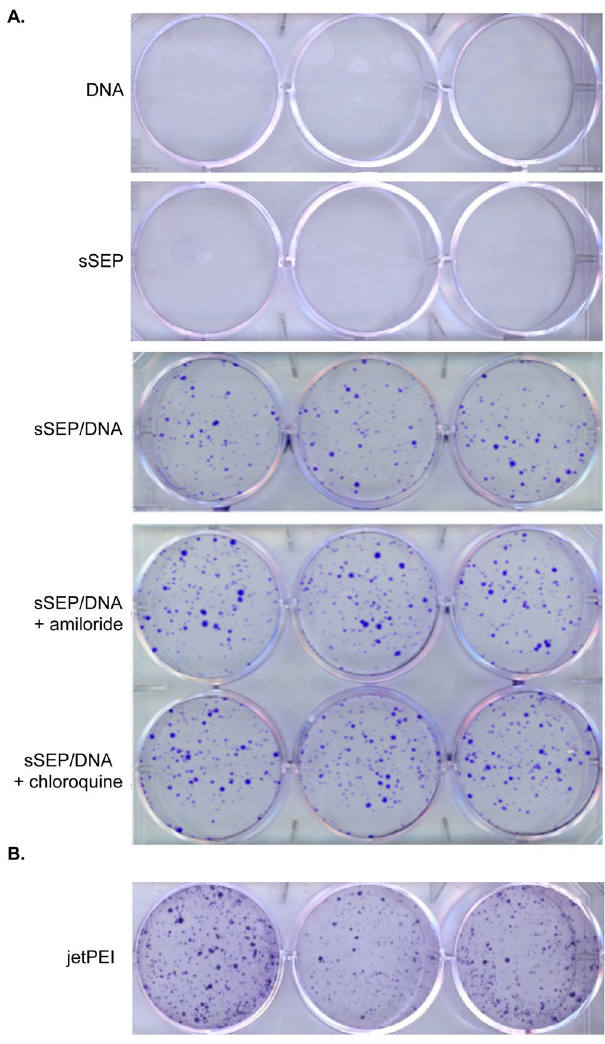
Figure 6. DNA transfer into human cells. (A ) A comparison of the number of colonies of transfected U2OS human cells with sSep/DNA (triplicates), and sSep/DNA biohybrids after incubation with 100 μ M Amiloride (triplicates) and 10 μ M chloroquine (triplicates). ( B ) Transfection of U2OS cells using